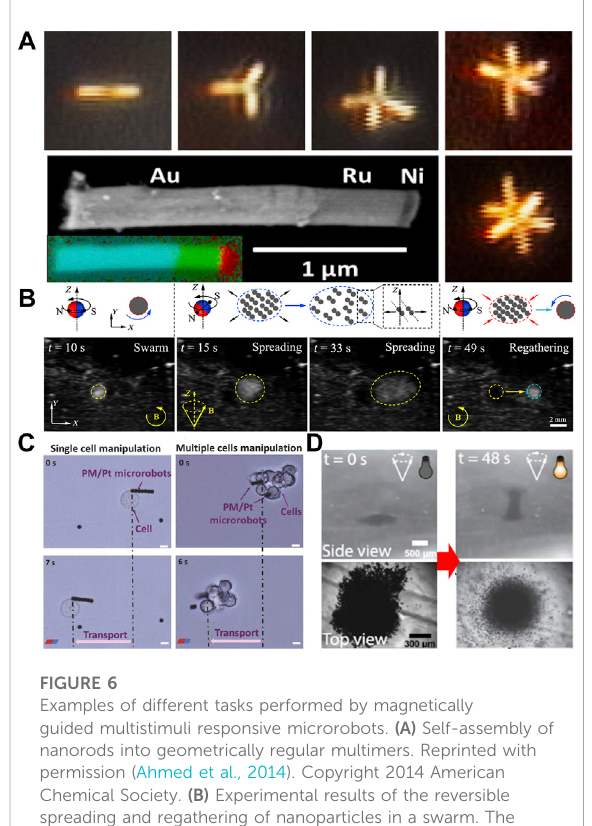
FIGURE 6 Examples of different tasks performed by magnetically guided multistimuli responsive microrobots. (A) Self-assembly of nanorods into geometrically regular multimers. Reprinted with permission (Ahmed et al., 2014). Copyright 2014 American Chemical Society. (B) Experimental results of the reversible spreading and regathering of nanoparticles in a swarm. The applied fi elds are shown schematically. (Wang et al., 2021). Copyright 2021 American Association for the Advancement of Science (C) Cell manipulation by a chain of